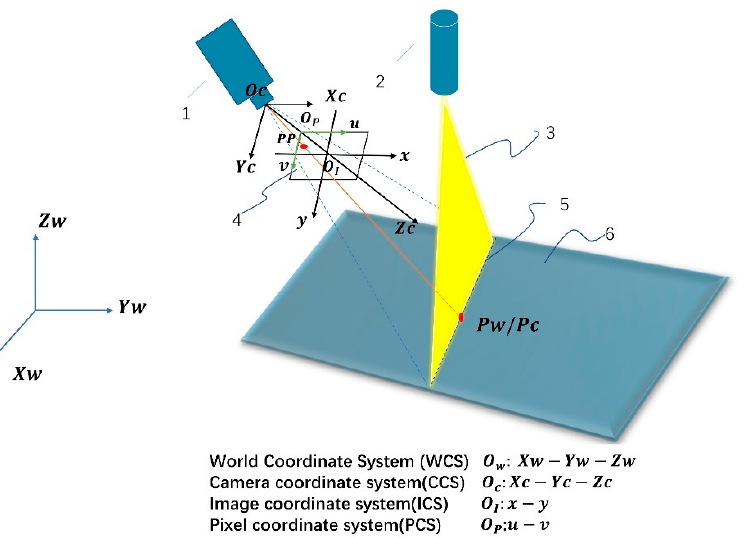
Figure 2. The geometric structure of the line structured vision sensor. (1) Camera, (2) Single-line laser, (3) Laser projector, (4) Image plane, (5) Light stripe, (6) Experiment platform.